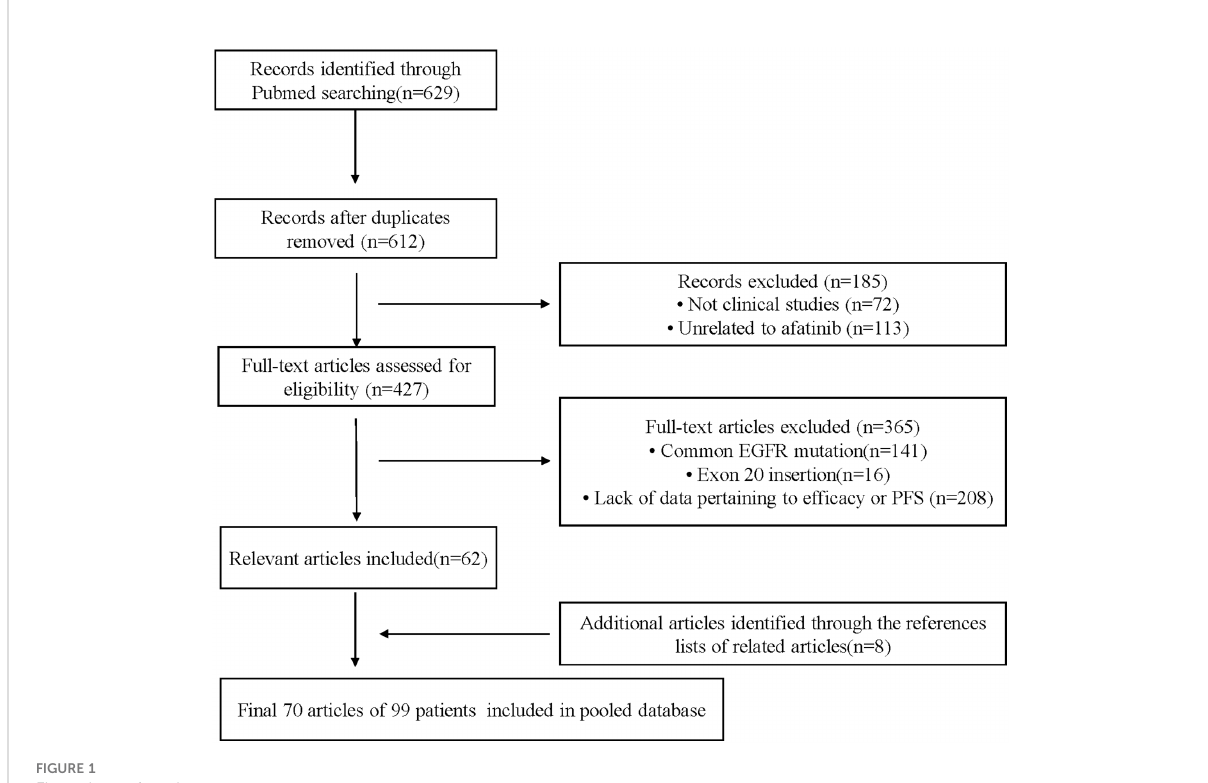
FIGURE 1 Flow chart of study